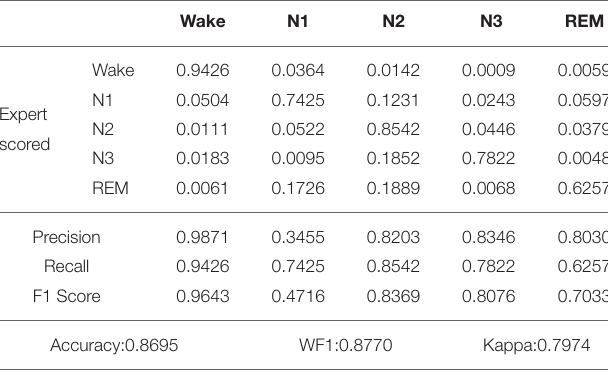
TABLE 4 | Confusion matrix and classification performance of proposed model applied on Sleep-EDF dataset after increasing the weight of the N1 state.